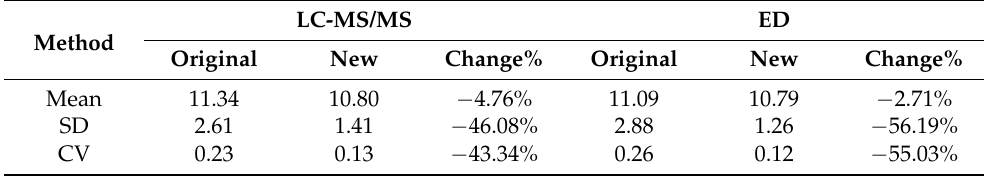
Table 3. Mean, SD and CV of FT4 transformations into IA scale by linear transformation.